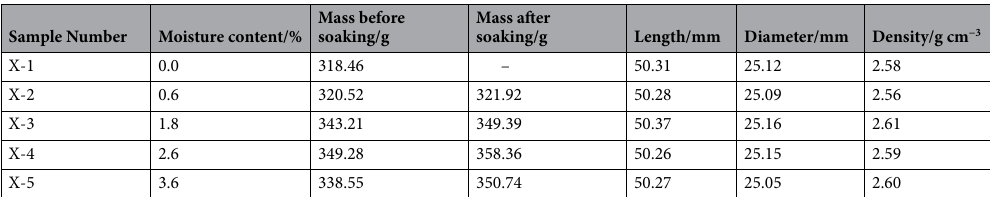
Table 1. Experimental sample parameters.